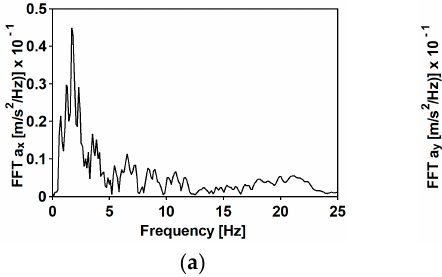
Figure 9. The time history of the registered ground acceleration for the second mining-induced